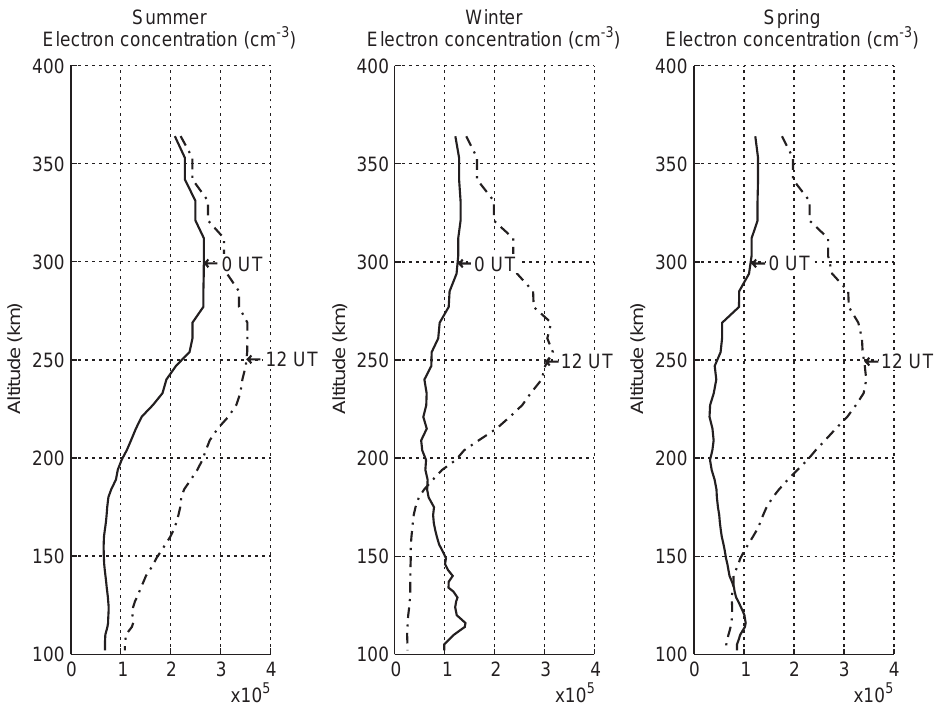
Fig. 8. The average ionospheric density at noon and midnight for low solar activity for